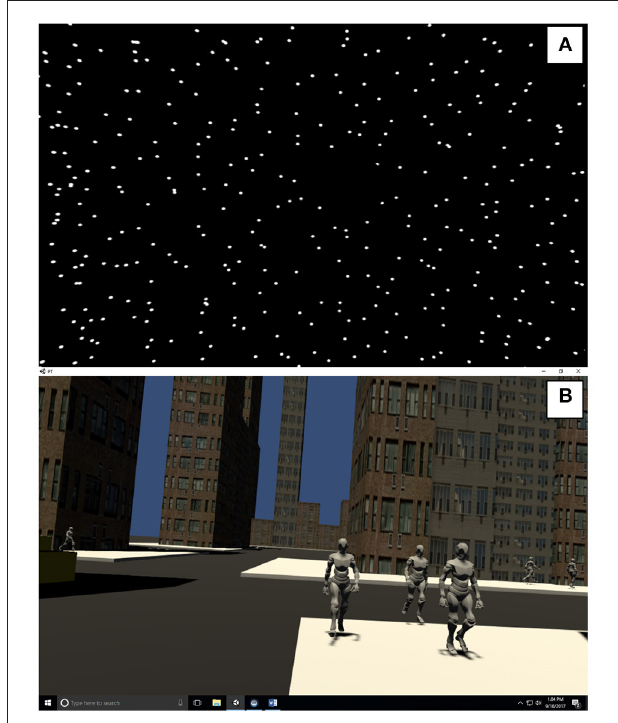
FIGURE 1 | A screenshot of the Stars scene (A) and the City scene (B) .